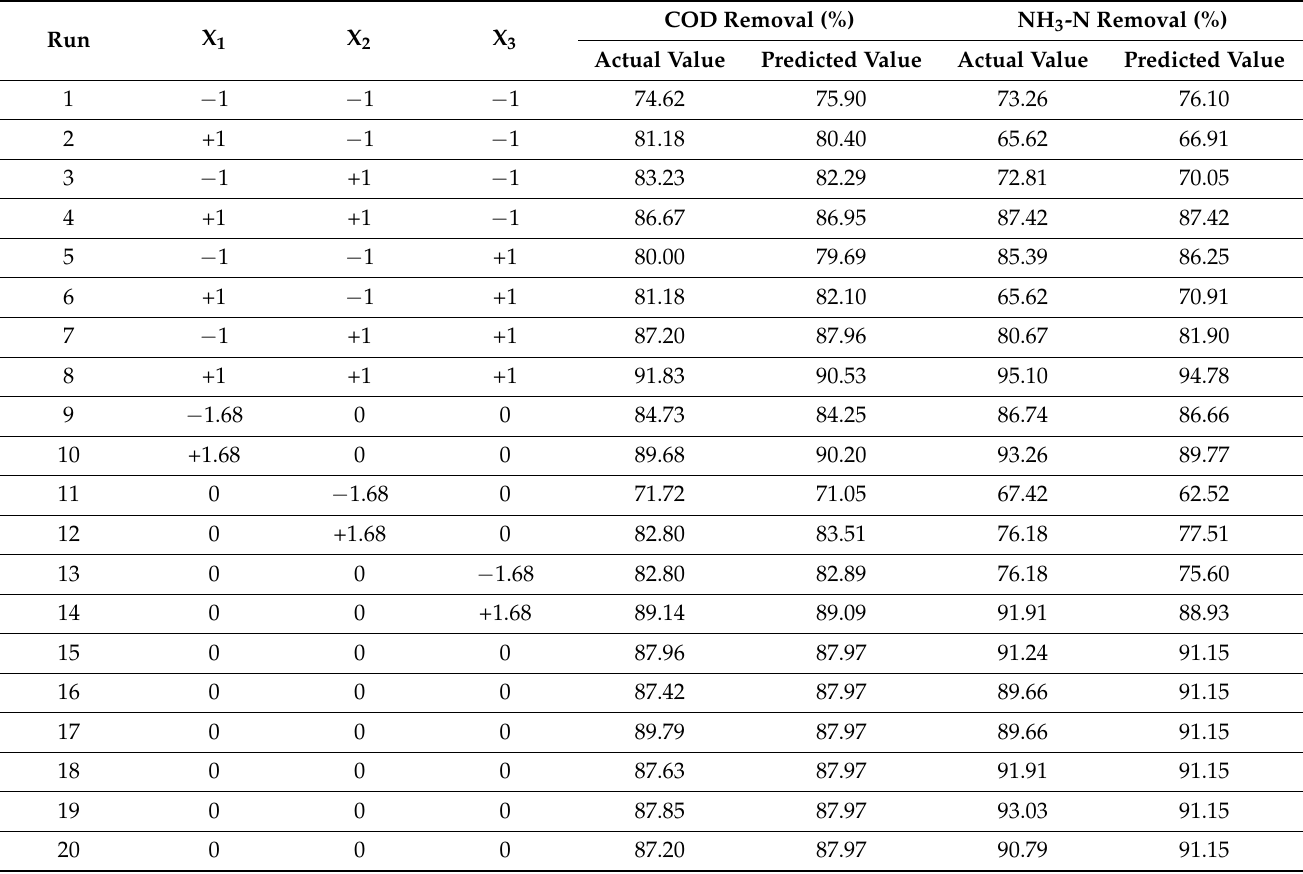
Table 3. Actual and predicted values for eliminating COD and NH 3 -N from SRPE using FeSO 4 · 7H 2 O waste as a